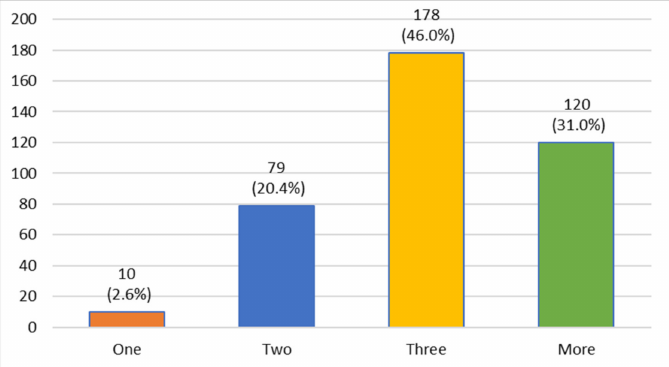
Figure 11. Distribution of the answers given by children regarding number of meals. The majority of adults choose their food based on their preferences (75.3%, n = 287), while 9.4% ( n = 36) follow their health issues or choose in order to prevent a possible health issue (11.3%, n = 43) (Figure 12).